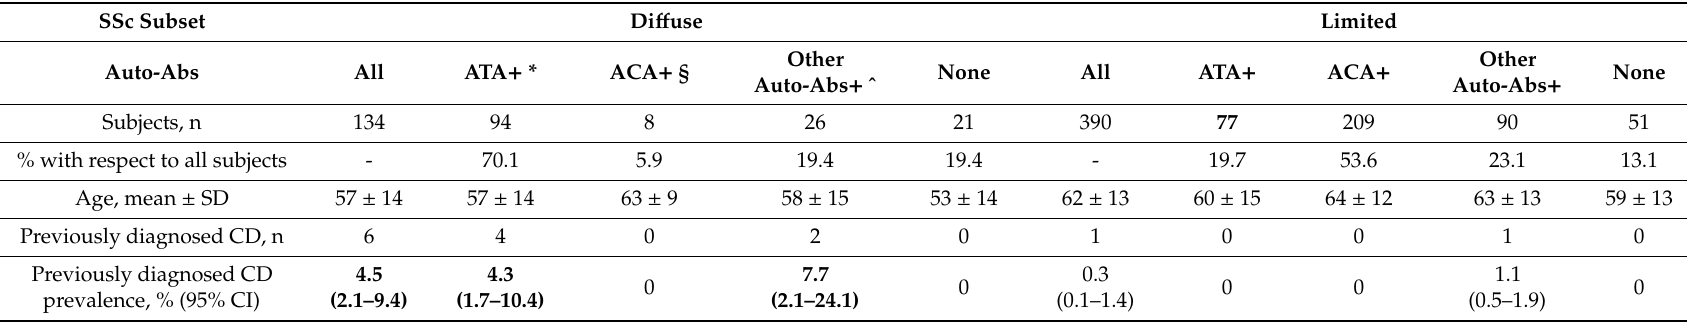
Table 5. Epidemiological features of, and celiac disease prevalence in patients with systemic sclerosis according to di ff erent clinical subsets and specific serology. SSc Subset Di ff use Limited Auto-Abs All ATA +